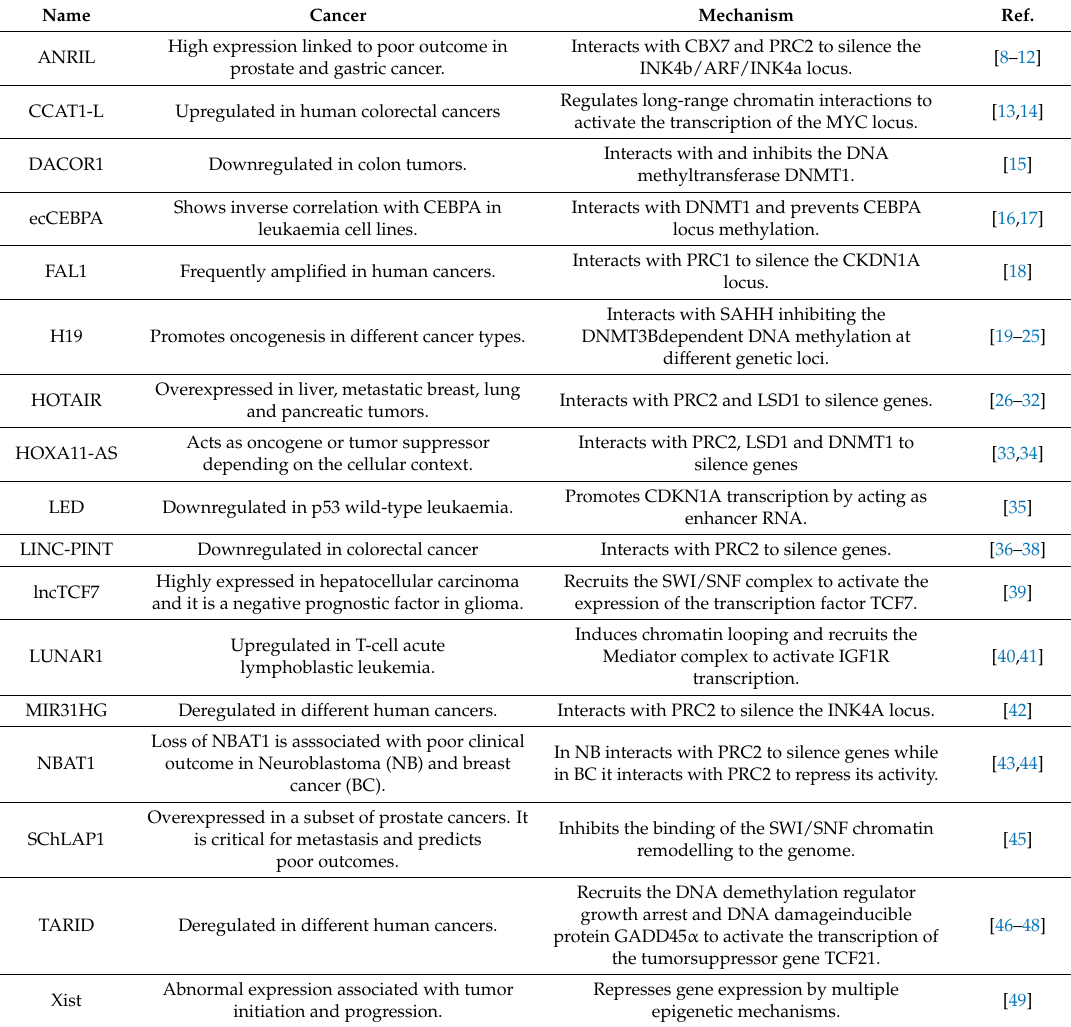
Table 1. LncRNAs with an epigenetic function in